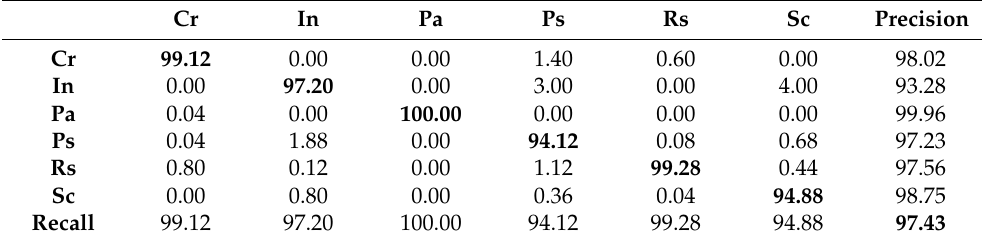
Table 9. The confusion matrices when adopting the MRFFN+IA method on motion length 20 task containing six types of defects (%), where Cr, In, Pa, PS, RS, and Sc denote the crazing, inclusion, patches, pitted surface, rolled-in scale, and scratches defects